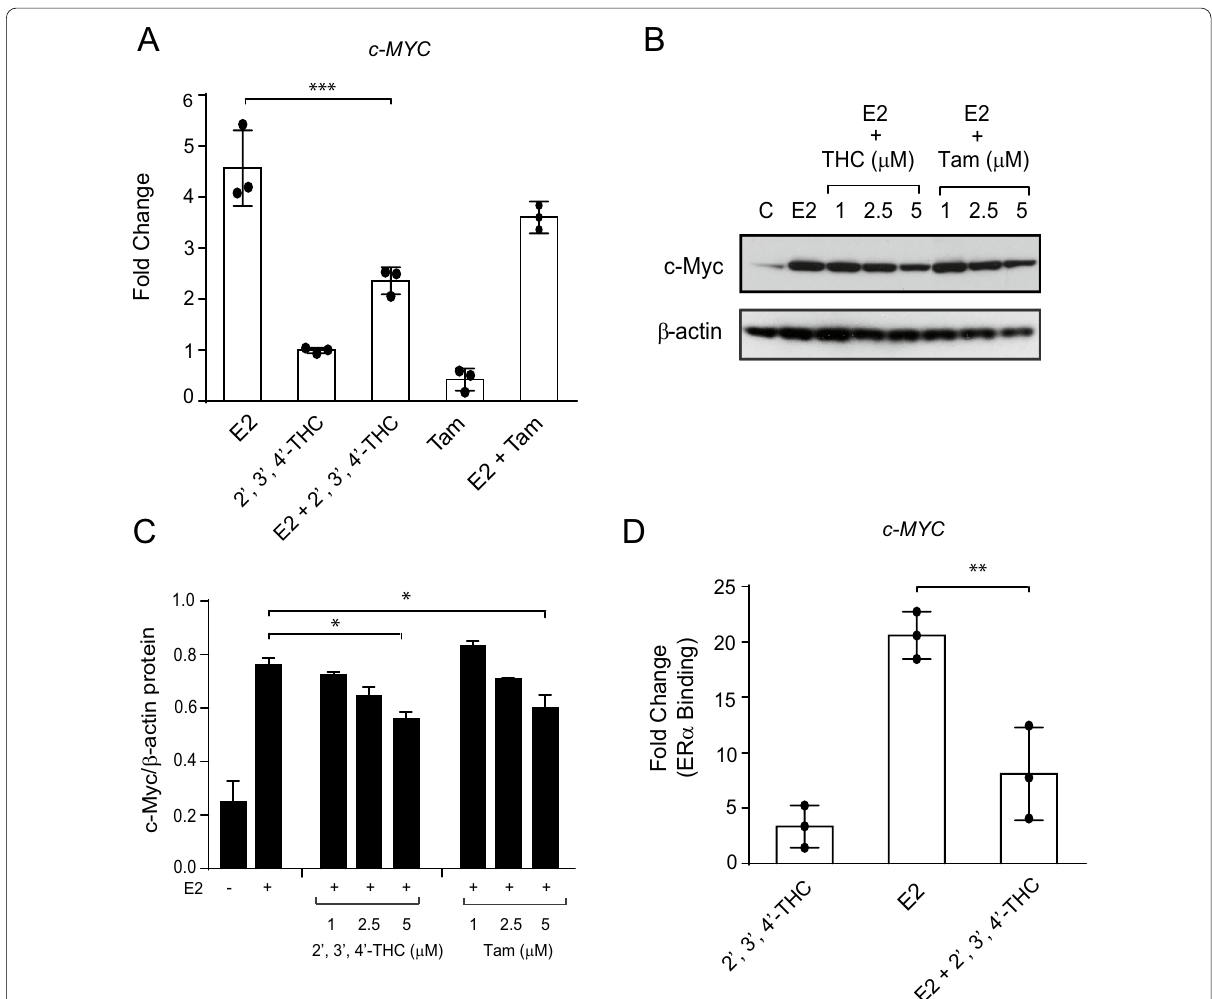
Fig. 8 2 ′ ,3 ′ ,4 ′ ‑THC inhibits E2 activation of the c-MYC gene. A MCF‑7 cells were treated with 10 nM E2, 5 μM 2 ′ ,3 ′ ,4 ′ ‑THC, and 5 μM Tam alone or in combination for 2 h and the levels of c-MYC mRNA were measured by qRT‑PCR. The error bars are means of c‑MYC protein levels. The cells were treated with 10 nM E2 alone or in combination with increasing doses of 2 ′ ,3 ′ ,4 ′ ‑THC (THC) or Tam for 3 h and c‑MYC was determined by western blotting. C Quantification of c‑MYC protein levels in cells treated with E2 and 2 ′ ,3 ′ ,4 ′ ‑THC or Tam. D 2 ′ ,3 ′ ,4 ′ ‑THC inhibits E2‑induced ERα recruitment to c-MYC enhancer region. The cells were treated with 10 nM E2 without or with 5 μM 2 ′ ,3 ′ ,4 ′ ‑THC for 1 h and ERα binding was determined by ChIP assay. Each bar represents the mean of triplicate samples between E2 alone and various treatments determined by one‑way ANOVA followed by Tukey’s multiple comparisons post hoc